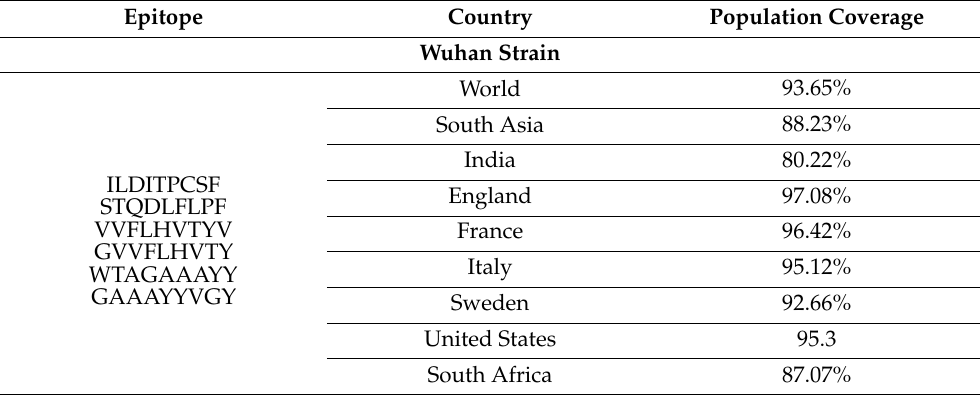
Table 6. Population coverage and the distribution of immunogenic T-cell epitopes of SARS-CoV-2